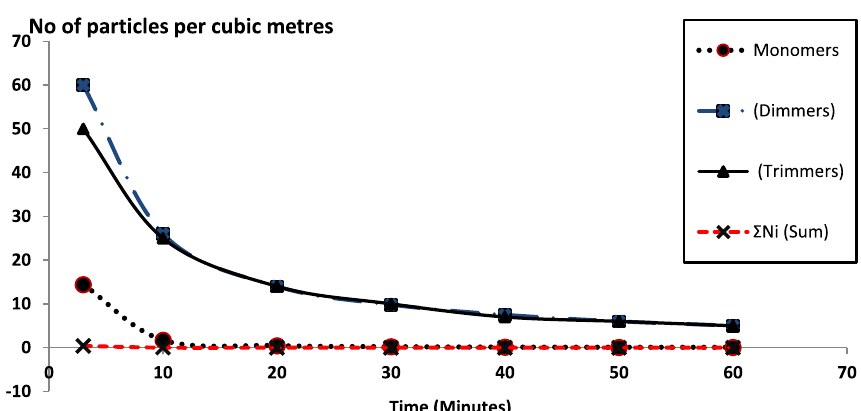
Fig. 6 Time-evolution aggregation and distribution of colloidal particles at predicted